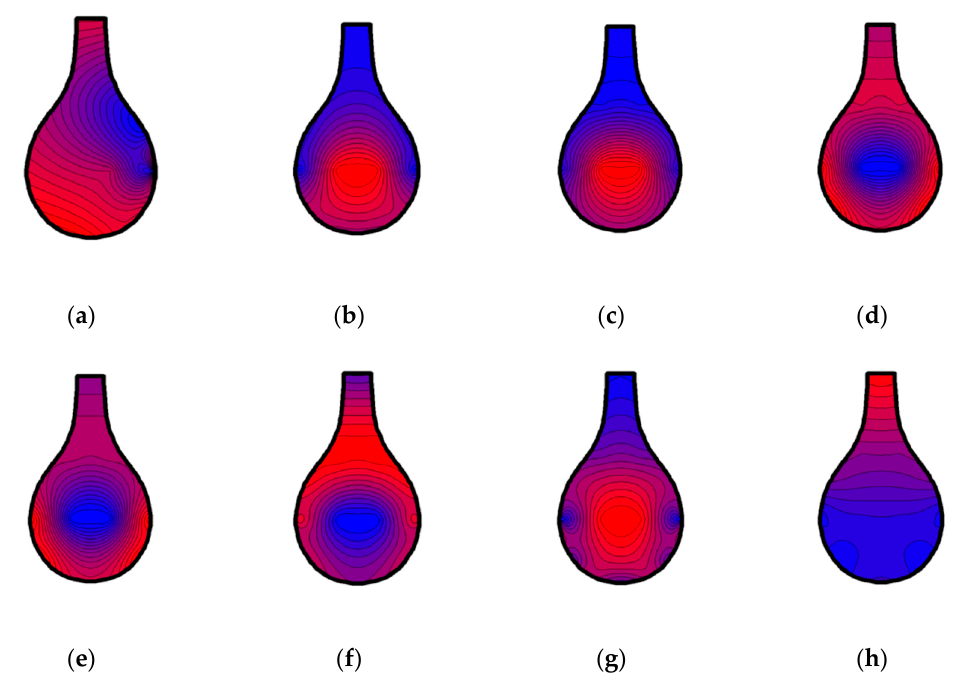
Figure 7. Results of modal analysis of the si-thar . Frequencies are ( a ) 53 Hz, ( b ) 139 Hz, ( c ) 172 Hz, ( d ) 226 Hz, ( e ) 269 Hz, ( f ) 322 Hz, ( g ) 549 Hz and ( h ) 645 Hz.